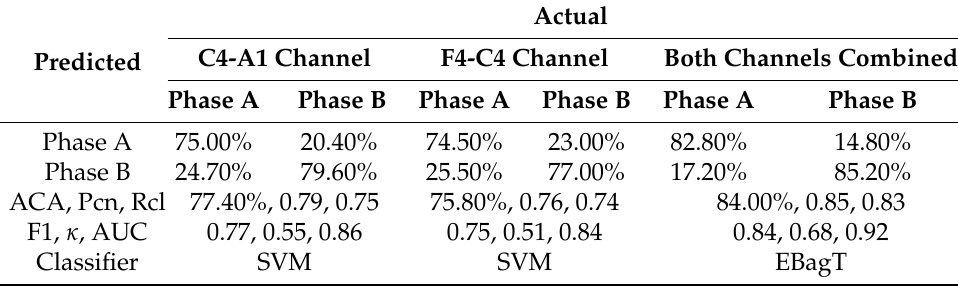
Table 7. Classification performance for NFLE subjects.